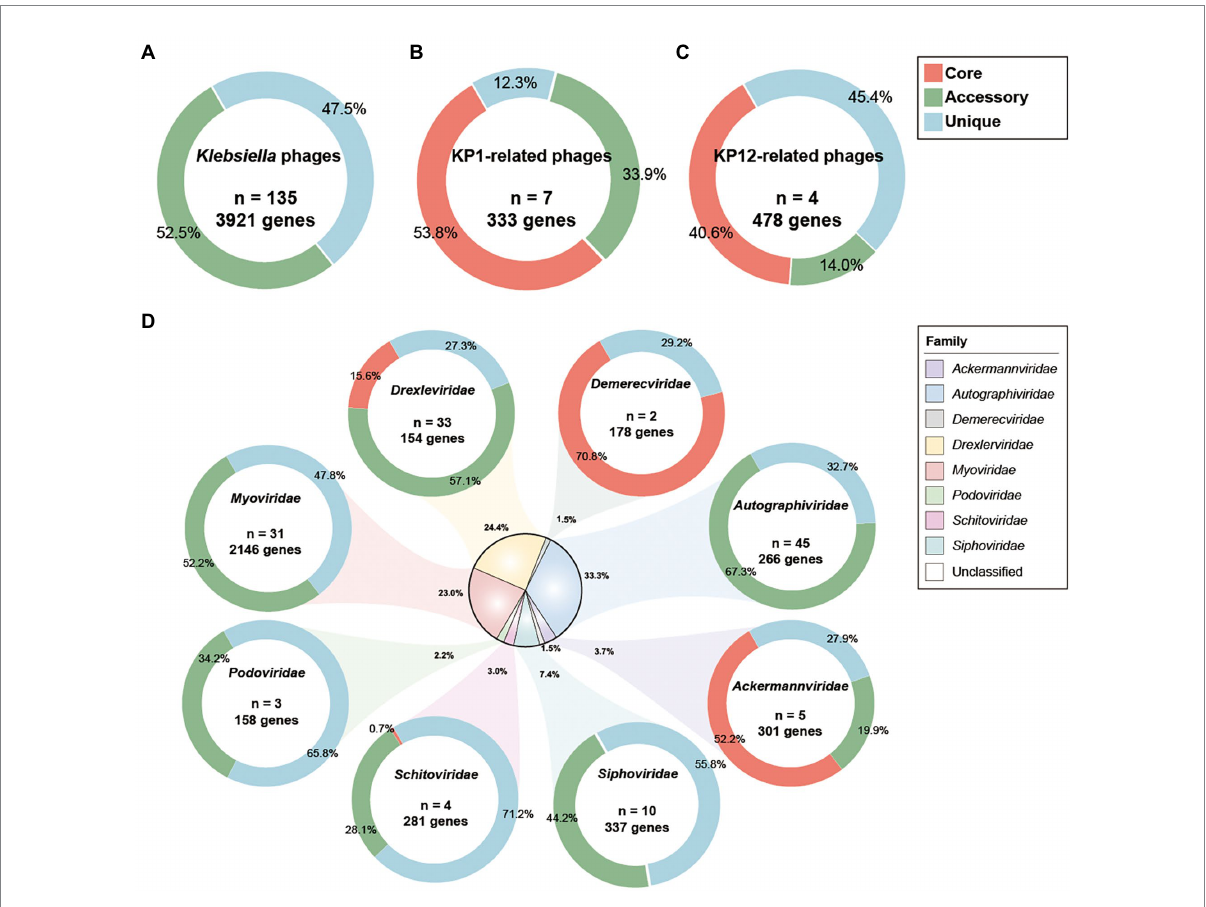
FIGURE 4 Pan-genome analysis of Klebsiella phages. Pan-genome analyses were performed for (A) 135 Klebsiella phages including KP1 and KP12, (B) KP1 and its closely related phages of Myoviridae family, (C) KP12 and its closely related phages of Myoviridae family, and (D) subgroup of 135 Klebsiella phages by their taxonomic family. The percentages of core (red), accessory (green), and unique genes (blue) were presented for each family. n indicates the number of strains for each